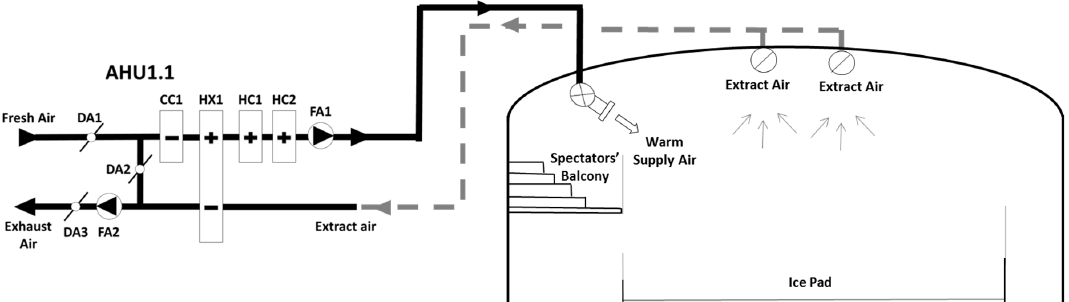
Figure 3. Schematic view of AHU1.1 and its corresponding air distribution.